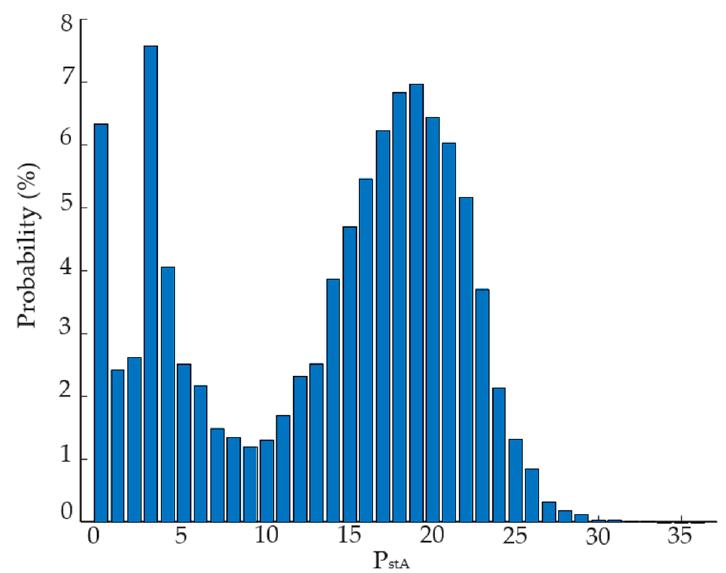
Figure 3. Histogram of recorded values P st . The first maximum on the histogram corresponds to the furnace being off. The second and third maxima occur when the furnace melts the charge. The third maximum